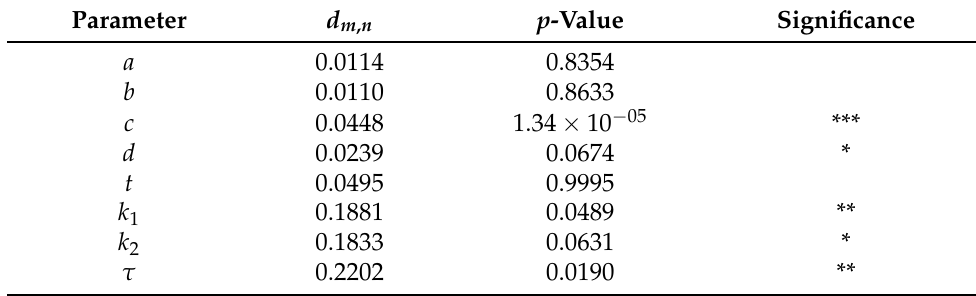
Table 3. RSA results for DAI − DA